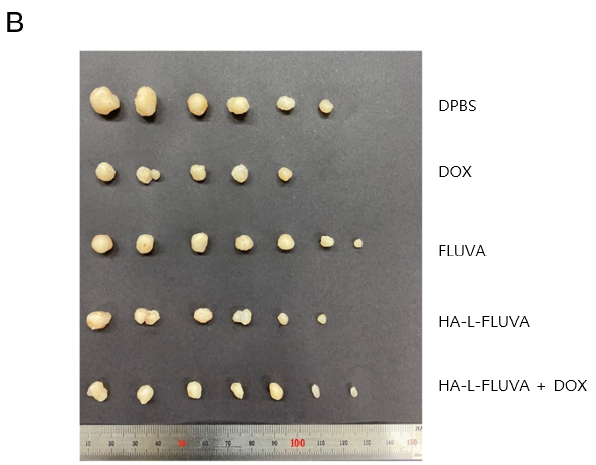
Figure 4. ( A ) Antitumor effect of HA-L-FLUVA in xenograft mouse models. Changes in tumor size in mice treated with Dulbecco’s phosphate buffered saline (DPBS), doxorubicin (DOX), FLUVA, HA-L-FLUVA, and HA-L-FLUVA + DOX (mean ± SD, * p < 0.05, ** p < 0.01). ( B ) Photographs of excised tumors from each group treated with DPBS, FLUVA, DOX, HA-L-FLUVA, and HA-L-FLUVA + DOX.